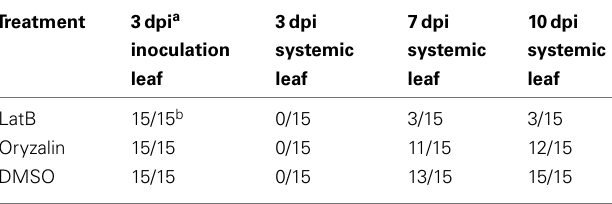
Table 1 | Effect of different inhibitors on RSV infection in